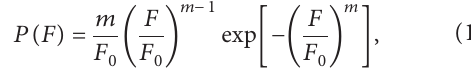
damage constitutive equation of frozen sand (formula (20)). The comparison chart of the theoretical curve and test curve under different principal stress coefficients is shown in Figure 8. The correlation coefficients of the experimental and theoretical curves at different temper- atures and intermediate principal stress coefficients are shown in Table 2. can fully reflect the entire process of frozen sand under loading. This reflects the fact that the strength of frozen sand is affected by temperature and the coefficient of intermediate principal stress. As the temperature de- creases and the coefficient of intermediate principal stress increases, the strength of frozen sand increases. From the correlation coefficient in Table 2, the experimental curve and theoretical curve fit well. However, when b � 0.5 and b � 0.75, the theoretical curve and the experimental curve do not match after the large principal strain reaches a certain value, and there is a large error in the model. Therefore, a reasonable correction method is needed to fully reflect the true triaxial damage constitutive